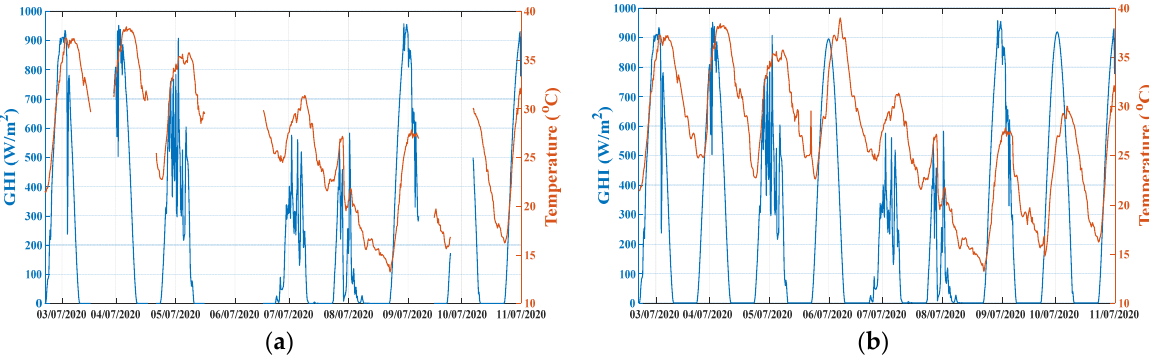
Figure 3. ( a ) Missing data of the GHI and the temperature on the site; ( b ) Time series reconstruction of the GHI and the temperature on the site.